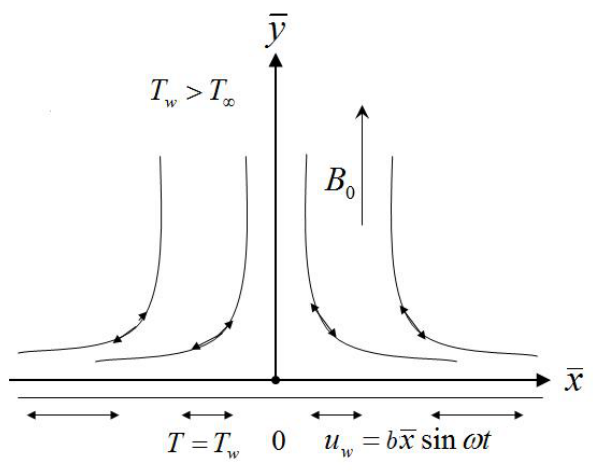
Figure 1: Geometry of the problem